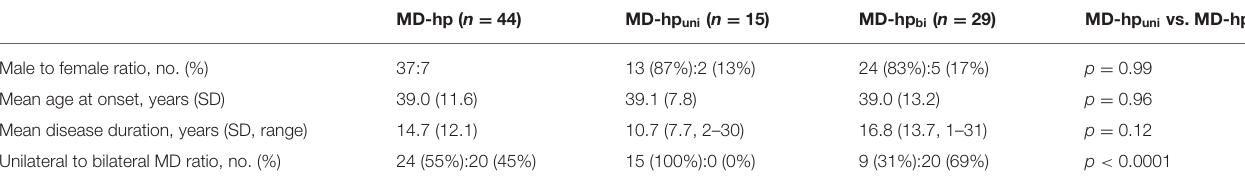
TABLE 1 | Demographics and clinical characteristics of the MD-hp